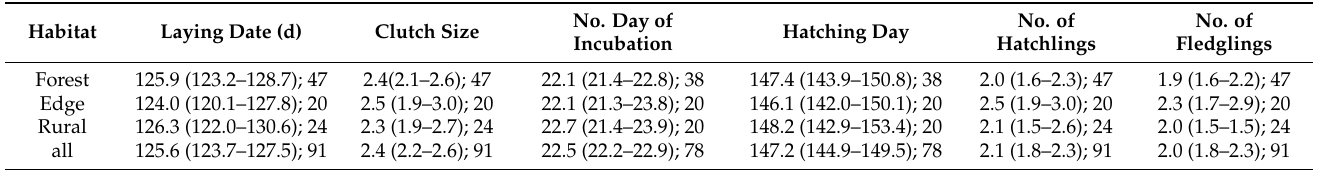
Table 1. Breeding parameters of the Cyprus Scops Owl Otus cyprius in nest boxes located in three types of habitats. Mean values are presented with 95% confidence limits in brackets and sample size. Dates of laying date and hatching day are presented in Julian